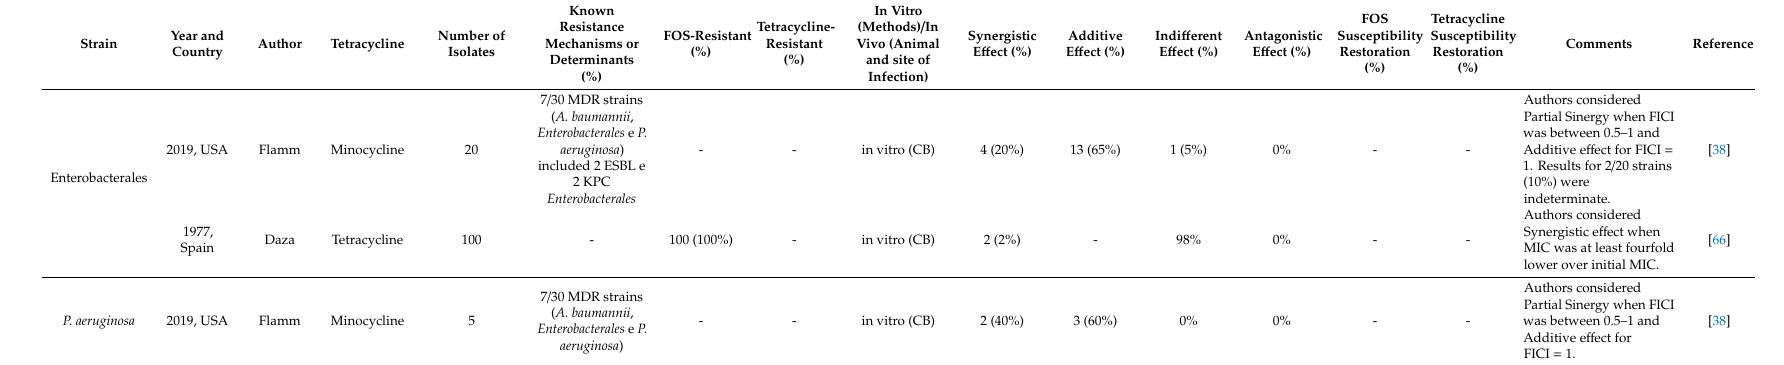
Table 9. Studies on combination between fosfomycin and tetracyclines. CB: checkerboard assay; TK: time–kill assay; ET: